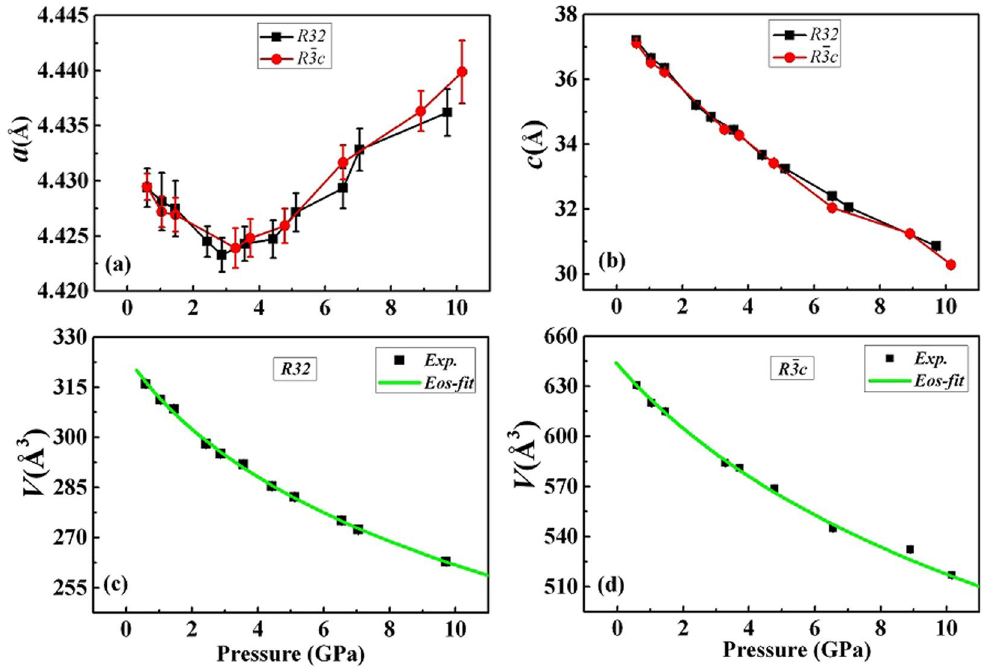
Figure 3. The pressure dependences of the lattice parameters a , c , and the volumes V of the R32 and the R c 3 KBBF are shown in ( a , b , c and d ), respectively. The green lines in ( c ) and ( d ) represent the best fit of the second- order Birch-Murnaghan equation of state for R32 and R c 3 ,